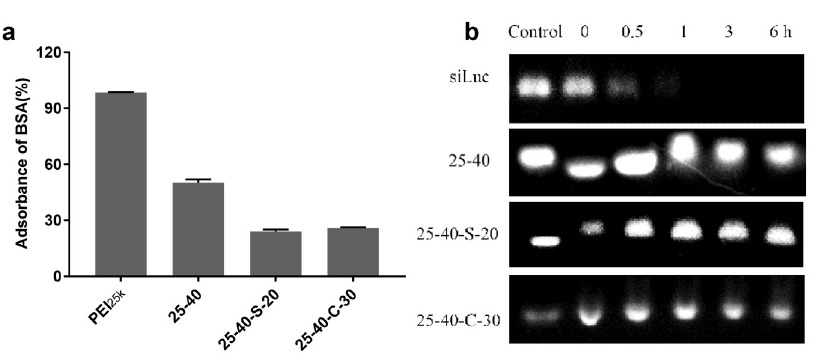
Figure 5. ( a ) Protein adsorption on selected H-zPEIs/siRNA NPs. ( b ) Stability of siRNA in selected H-zPEIs/siRNA NPs in 50% (v/v) fetal bovine serum by agarose gel retardation assay.